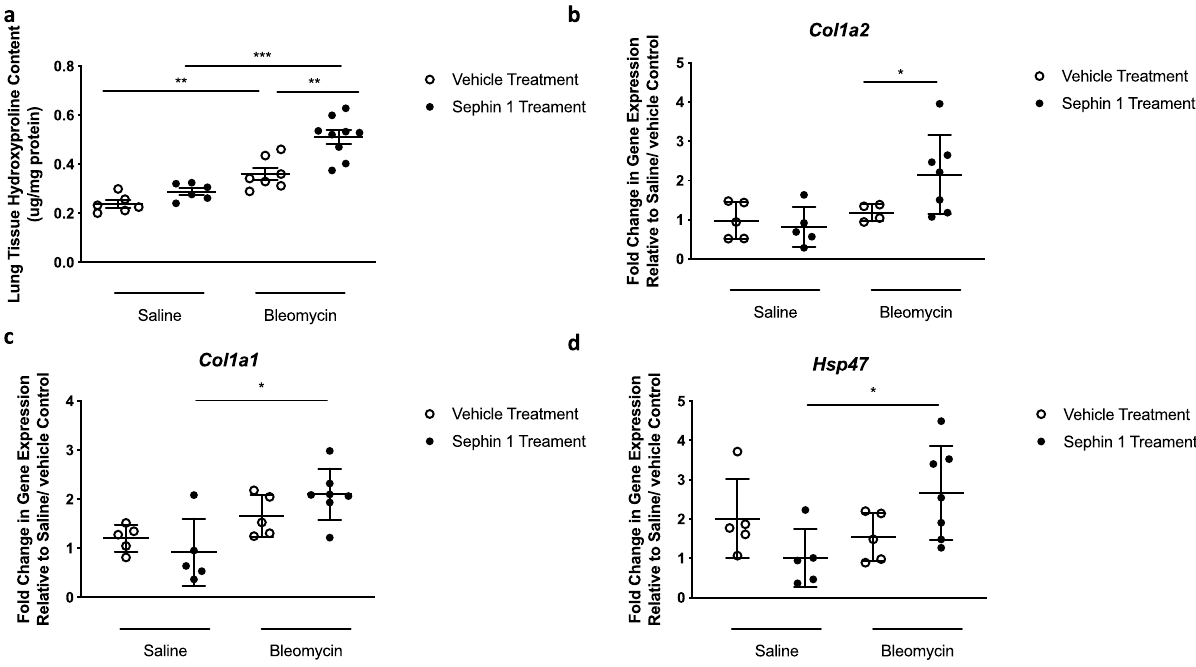
Figure 6. Pharmacological inhibition of PPP1R15A exacerbates bleomycin-induced lung fibrosis. C57Bl6 mice received oropharyngeal bleomycin or saline on Day 0 and were treated daily with Sephin1 (5 mg/kg, p.o.) or vehicle control (saline, 10 ml/kg p.o.) on Days 14–20. Mice were killed on Day 21 and lungs analysed for total collagen content via hydroxyproline assay ( a ) and total lung gene expression quantified for Col1a1 ( b ), Col1a2 ( c ) and Hsp47 ( d ) via RT-PCR. Data are shown as mean ± s.e.m. * P < 0.05, ** P < 0.01, *** P < 0.001 as